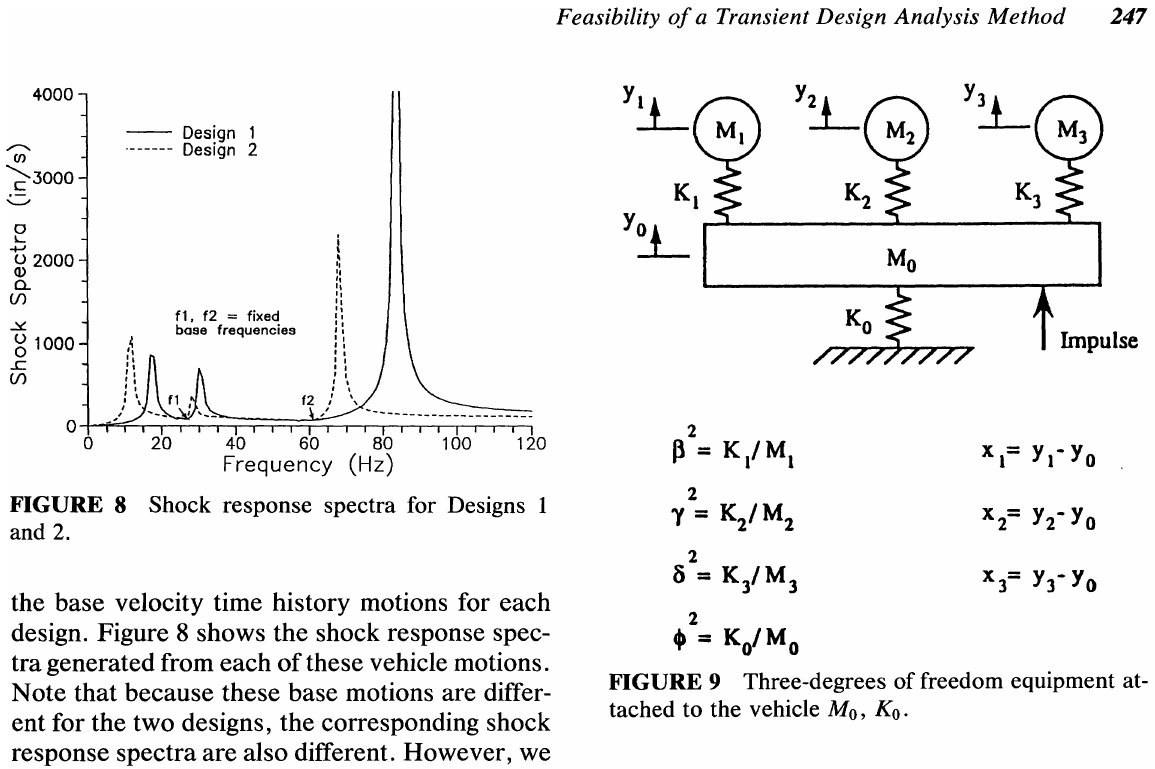
FIGURE 9 Three-degrees of freedom equipment at tached to the vehicle Mo,